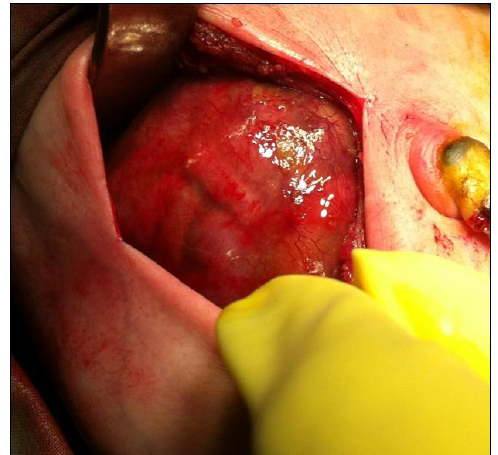
Figure 2: Entire bowel encased in the cocoon.